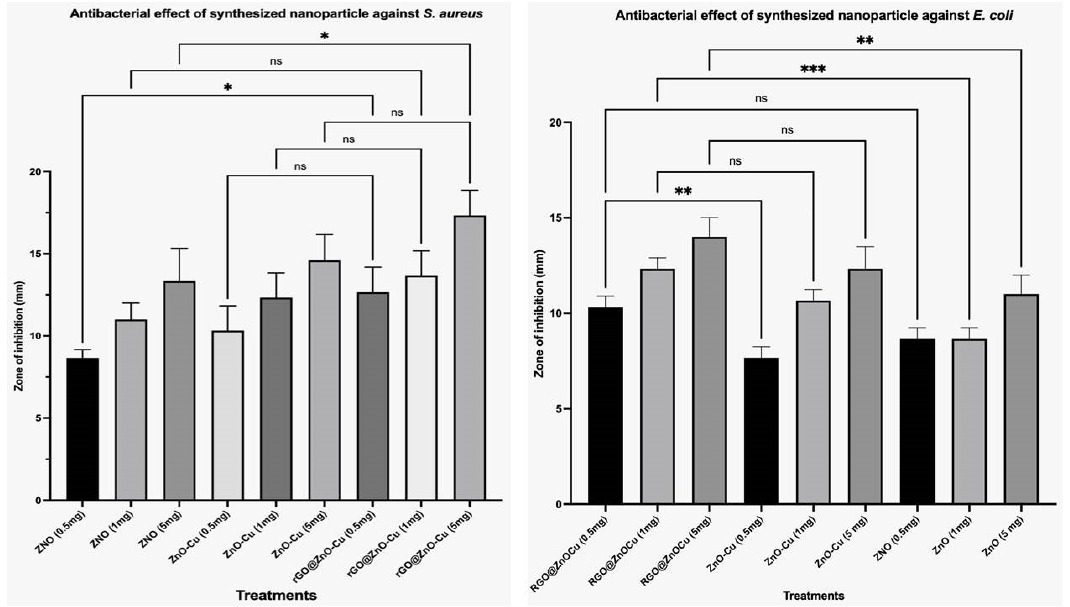
Figure 5. The antibacterial activity of rGO@ZnO–Cu nanoparticles against ( A ) S. aureus and ( B ) E.coli., p < 0.05 was considered statistically significant. (* p < 0.05, ** p < 0.005, *** p < 0.001).